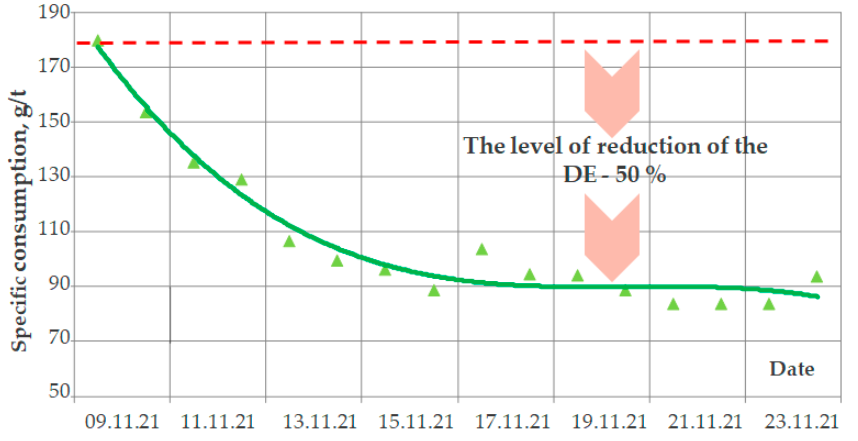
Figure 15. Diagram of determining the effectiveness of the Dissolvan 6070 demulsifier.